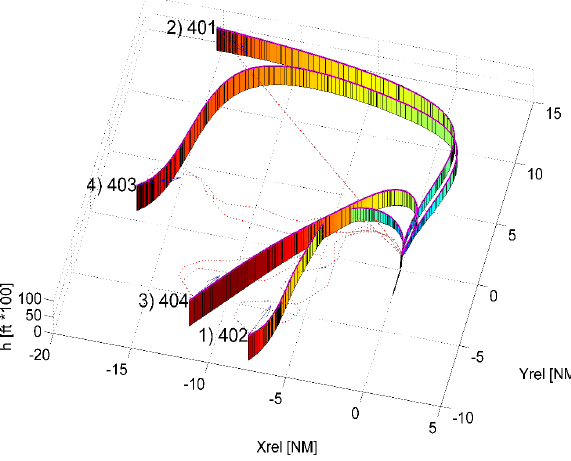
Fig. 8: Results of the pseudospectral 4D trajectory optimisation algorithm applied to the online TMA trajectory planning